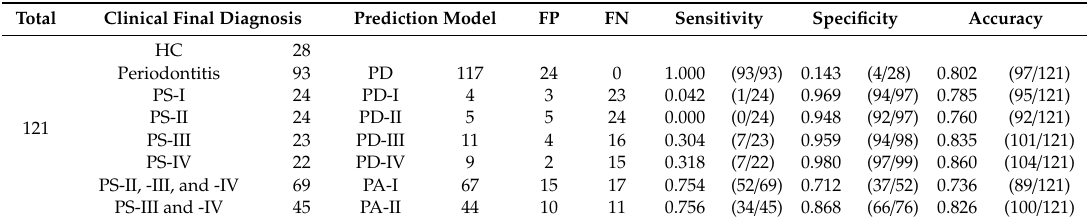
Table 3. The sensitivity, specificity, and accuracy of each prediction